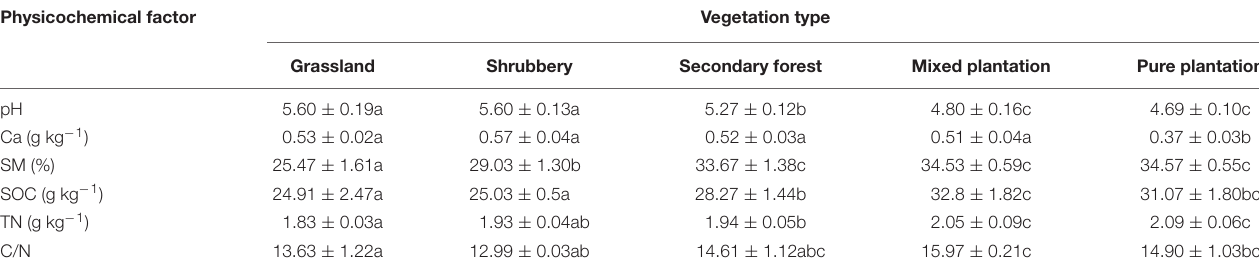
TABLE 1 | Soil physicochemical properties of five vegetation types. Physicochemical